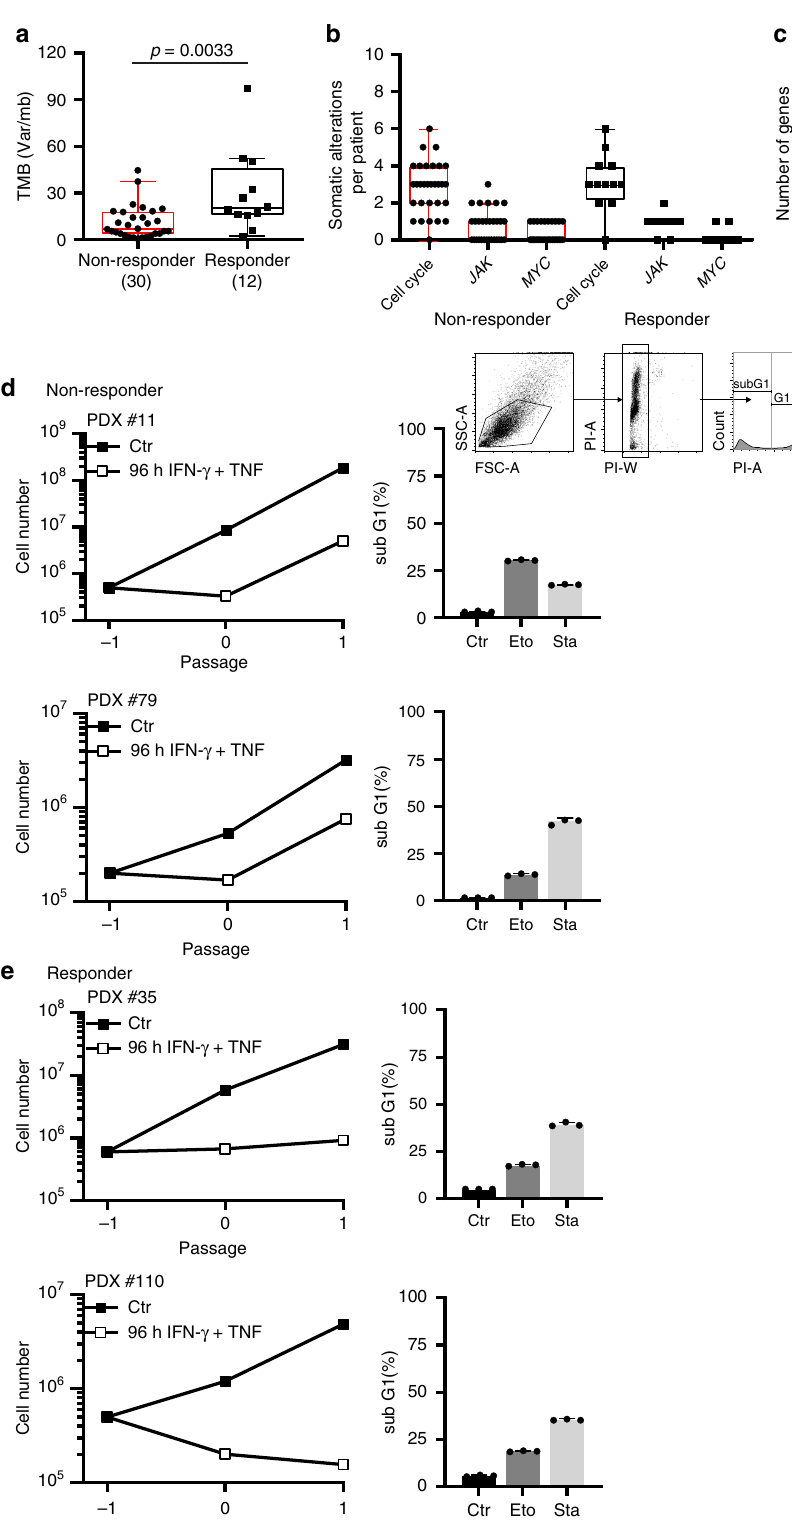
(100 μ m mesh). The melanoma cell suspension was implanted with Matrigel (Corning Life Sciences) subcutaneously in NSG (NOD. Cg-Prkdc scid Il2rg tm1Wjl /SzJ) mice, patient derived xenografts (PDX). Tumour grafts were harvested when they reached a diameter of 10 to 15mm, digested as above and the single cells were taken into culture using RPMI1640 with Hepes and L-Glutamine, containing 10% foetal bovine serum, 1% penicillin-streptomycin at 37°C with 5% CO 2 and 95% humidity. For cryo- preservation cell pellets were resuspended in Biofreeze medium